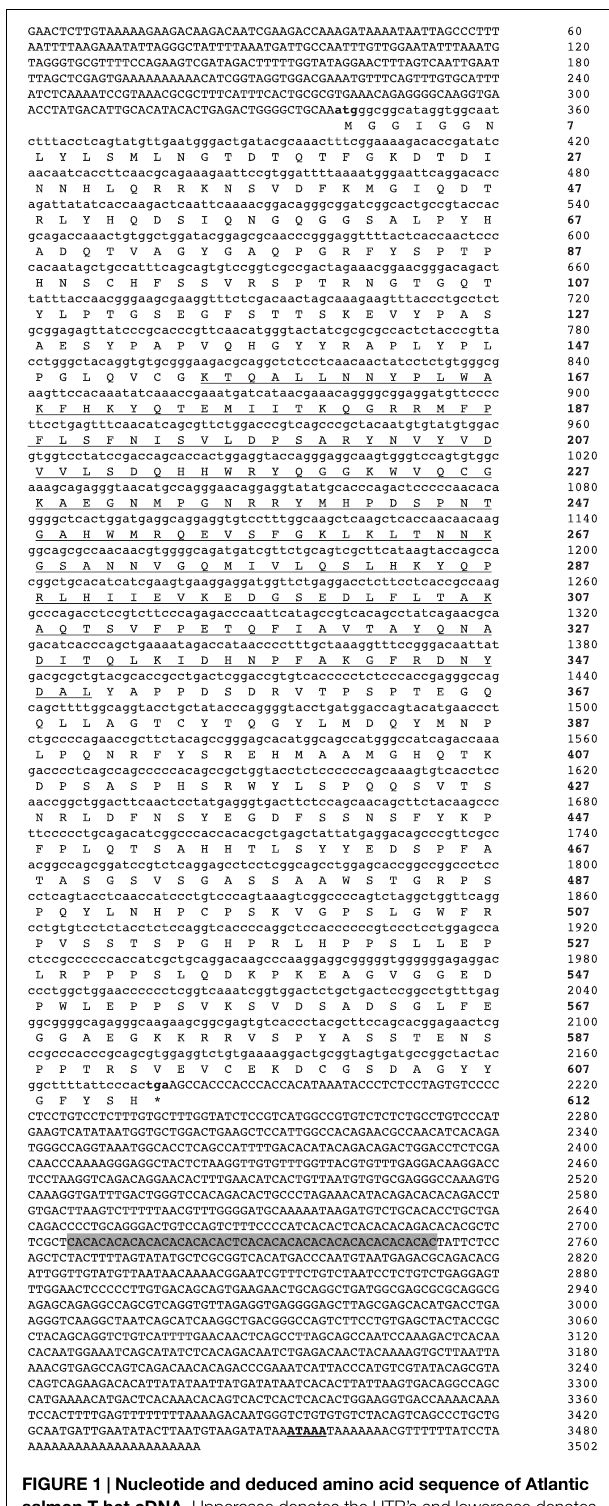
Frontiers in Immunology |